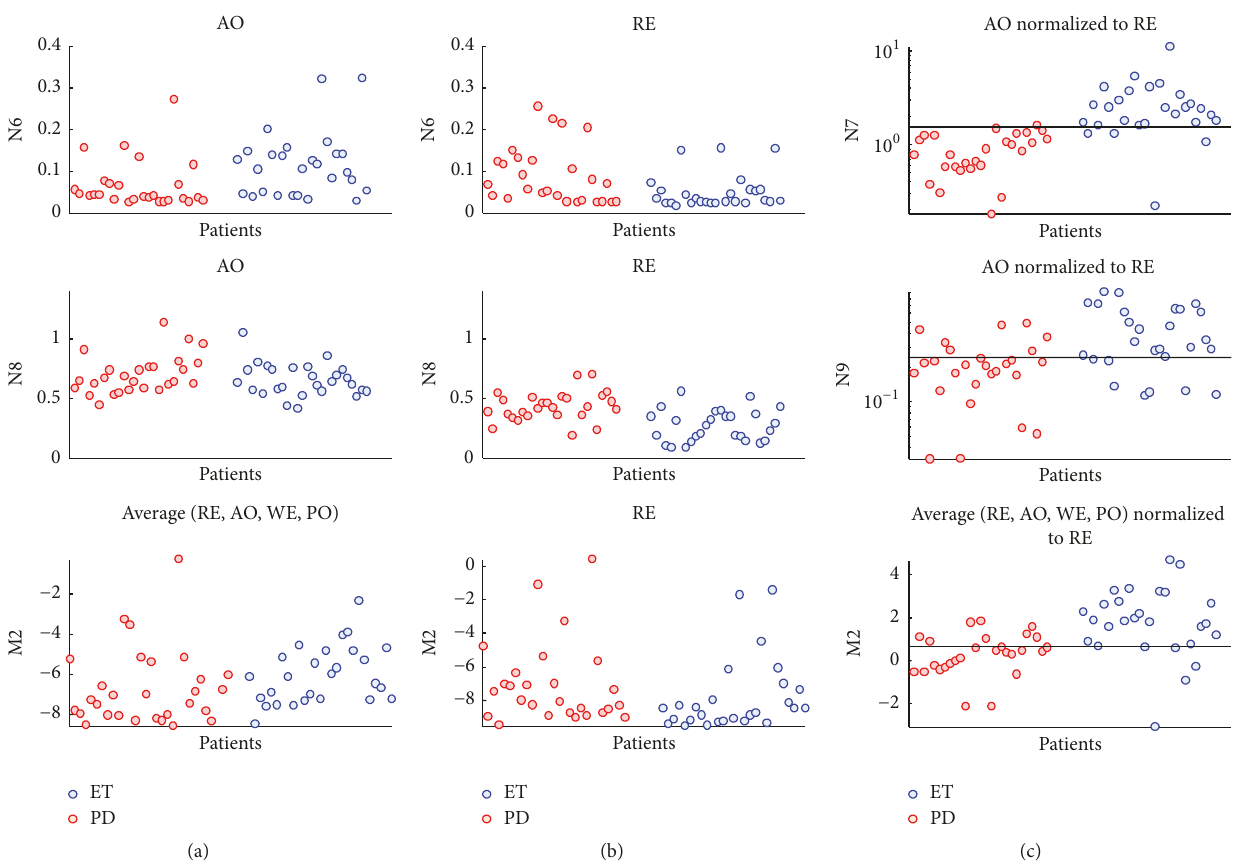
task (N7); the coefficient of variation for the pairwise motor unit synchronization (N9) in the AO task normalized to the RE task; and the mean log power of all the harmonics averaged over the AO, PO, WE, and RE tasks (M2) in the nondominant tremor hand. The same three tremor metrics were also proposed by logistic regression (results not